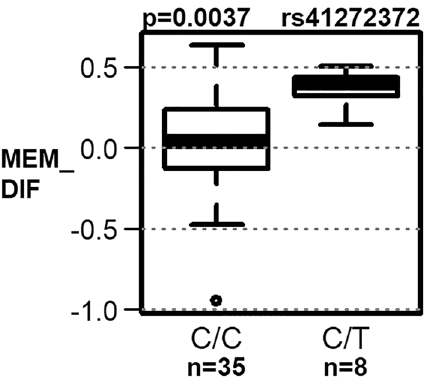
Figure 2. Association of polymorphism rs41272372 with MEM_DIF (average increase or decrease of the memory domain residual z-score in 2 years after the first examination) in naMCI group (statistically significant at a significance level of 0.1 after correction for multiple comparisons).